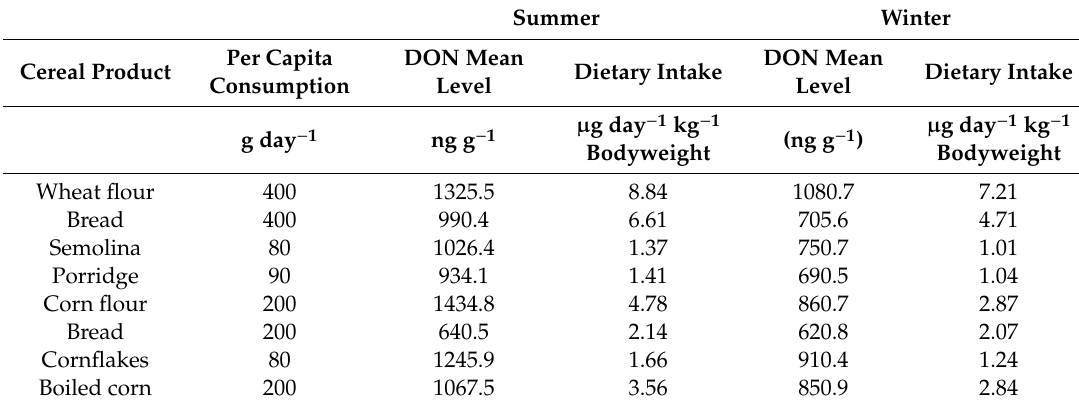
Dietary exposure assessment for DON in wheat, corn and products consumed by local